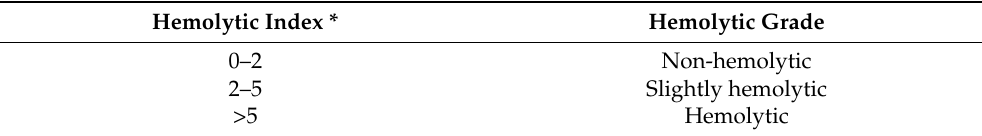
Table 3. Defined rates for hemolysis